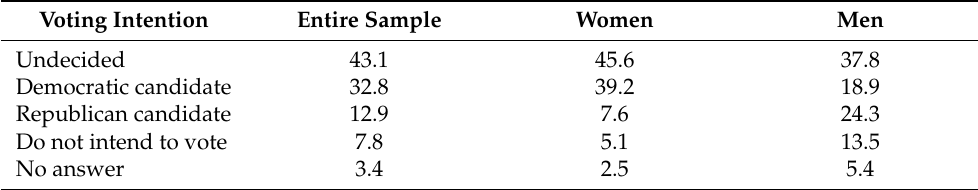
Table 1. Gender Differences in Voting Intentions for the 2020 US Presidential Election.